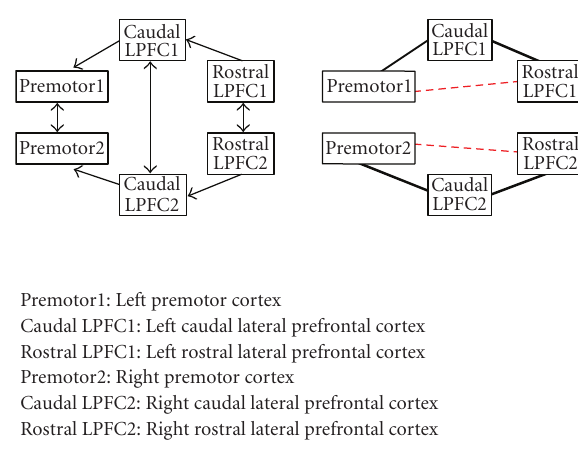
Figure 3: The network and results for Koechlin et al.